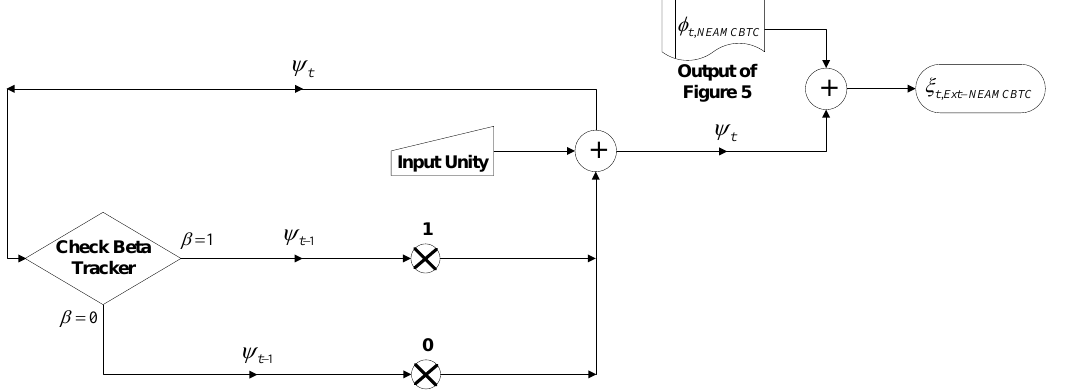
Figure 6. Data flow diagram of the Ext-NEAMCBTC